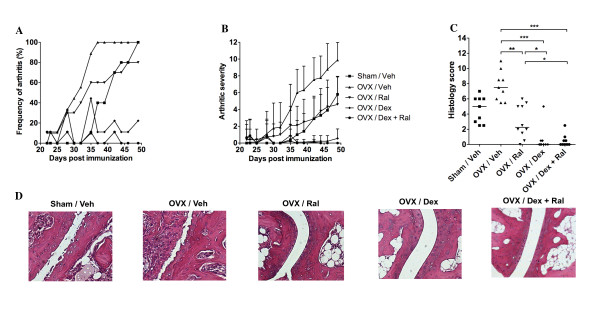
Treatment with dexamethasone alone or in combination with raloxifene reduces arthritis and protects against joint destruction. Female sham-operated (n = 10) or ovariectomy (OVX) mice treated with vehicle (Veh; n = 9), raloxifene (Ral; n = 10), dexamethasone (Dex; n = 9), or a combination of both Dex and Ral (n = 9) were used in order to evaluate the effects of treatment on arthritis and bone mineral density (BMD). Treatment was administered five days per week, starting after the first appearance of arthritis (day 22), and continued until the termination of the experiment (day 49). (a) Frequency and (b) severity were evaluated every two to three days. Severity is expressed as the mean ± standard deviation in each group. (c) Histologic destruction scores of paw sections. Scatter plots show the scores of individual mice, and bars show the median in each group. (d) Representative images of paw tissue sections, revealing the effects of treatment on histologic features in each group. The non-parametric Kruskall-Wallis test with post hoc comparison was used for statistical evaluation of all parameters, *P<0.05, **P<0.01, ***P<0.001.